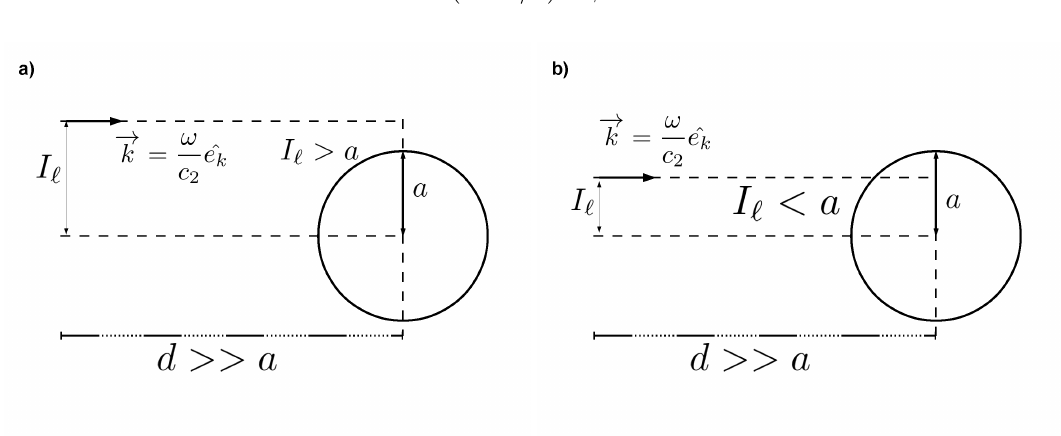
Figure 4 - Shows the scattering geometry in two distinct situations. In ( a ) is the case where the magnitude of the impact parameter ( I (cid:96) ) is I (cid:96) > a and in ( b ) is I (cid:96) < a